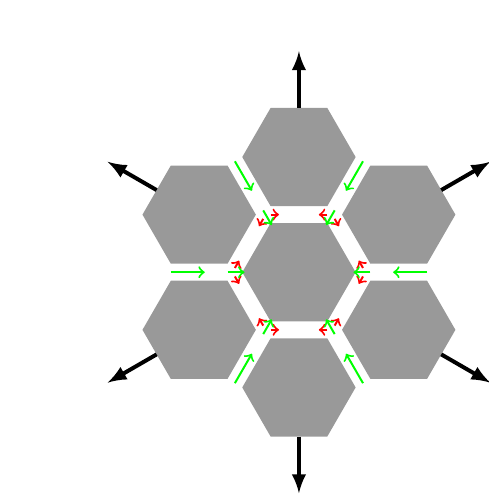
Figure 1: First ring of assemblies in steady state (left) and excited